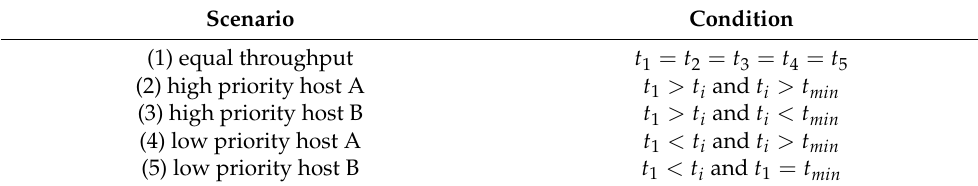
Table 5. Target throughput conditions in five